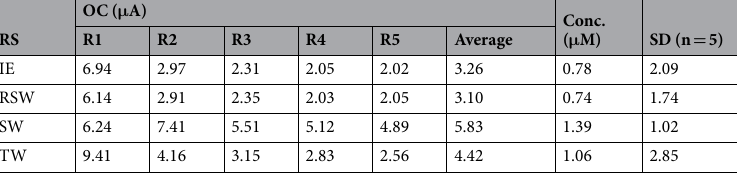
Table 4. Analysis of real samples by MNBBSH/GCE sensor. RS: Real sample , IE: Industrial effluent , RSW : Red sea water , SW : Surface water , TW : Tap water , R : Reading , OC : Observed current , and SD : Standard deviation